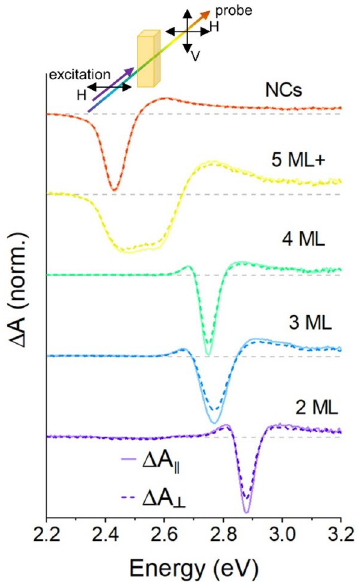
Fig. 4 Polarized transient absorption spectroscopy for NPLs and NCs with data showing the transient absorption spectrum at 10 ps pump-probe delay with 3.54 eV pump photon energy. The inset shows the geometry of the measurement; a horizontally-polarized pump excites the toluene-dispersed samples and vertical and horizontal probe components are separated after the sample using a polarizer. ΔA signals are shown co-polarized (solid lines) and cross-polarized (dashed